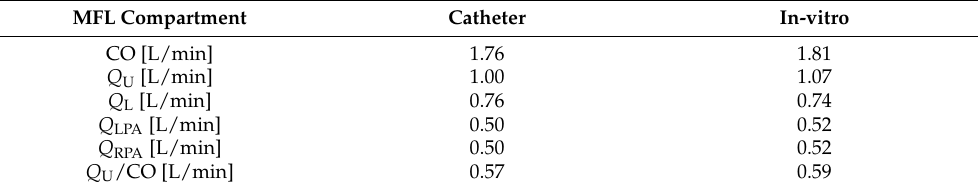
Table 8. Comparison of cycle averaged flow rate [L/min] of patient 2 between catheter reports and in-vitro measurements.